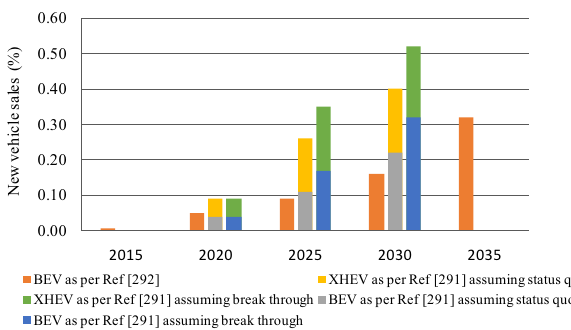
Fig. 7 Medium- and long-term sales of